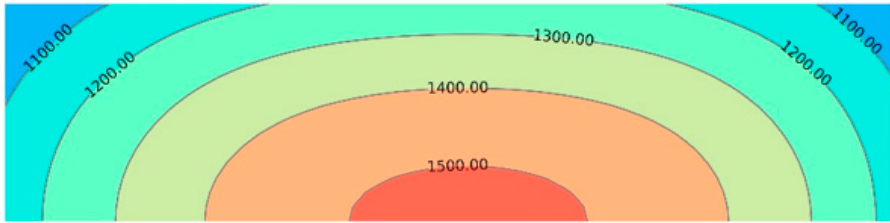
Figure 2. Temperature condition of RP process.